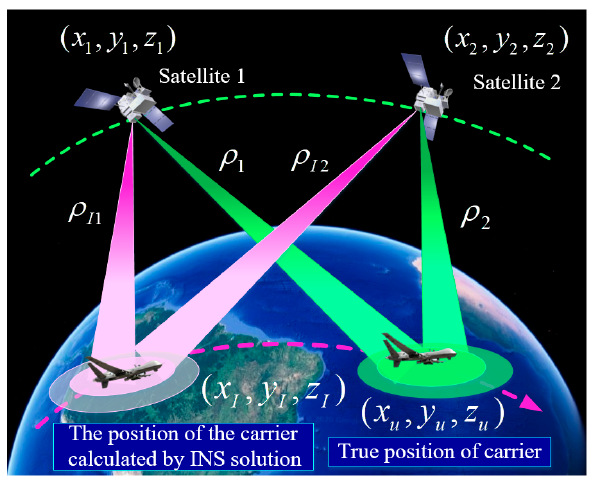
Figure 1. Schematic diagram of the standard INS+LEO2-satellite integrated navigation algorithm. According to Figure 1, assuming that the position of satellite #1 in Earth-centered Earth-fixed (ECEF) coordinates is ( x 1 , y 1 , z 1 ) , the position of satellite #2 in ECEF coordinates is ( x 2 , y 2 , z 2 ) , the true position of the carrier in the ECEF coordinate system is ( x u , y u , z u ) , and the position calculated by INS is a known quantity ( x I , y I , z I ) , ρ 1 and ρ 2 represent the true ranging values of satellites #1 and #2, respectively. ρ I 1 and ρ I 2 represent the ranging values of satellite #1 and satellite #2 obtained by the INS extrapolation solution,